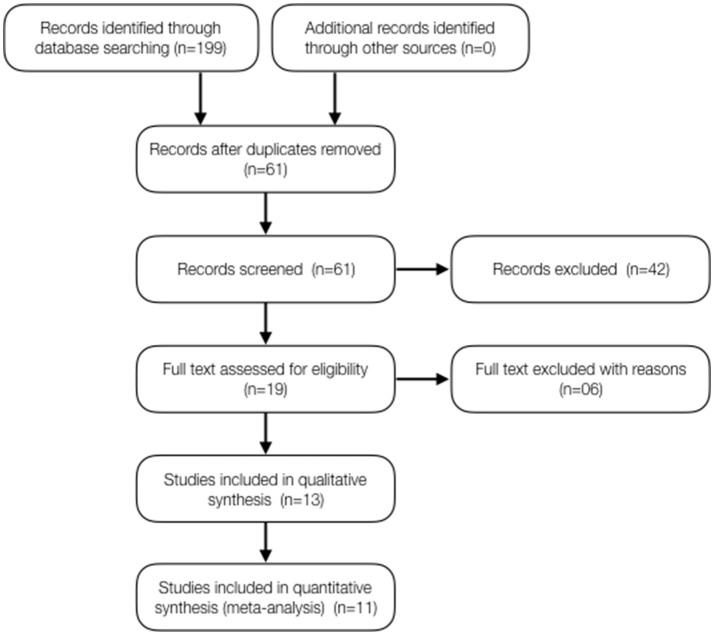
FLOW diagram of the reference searches.